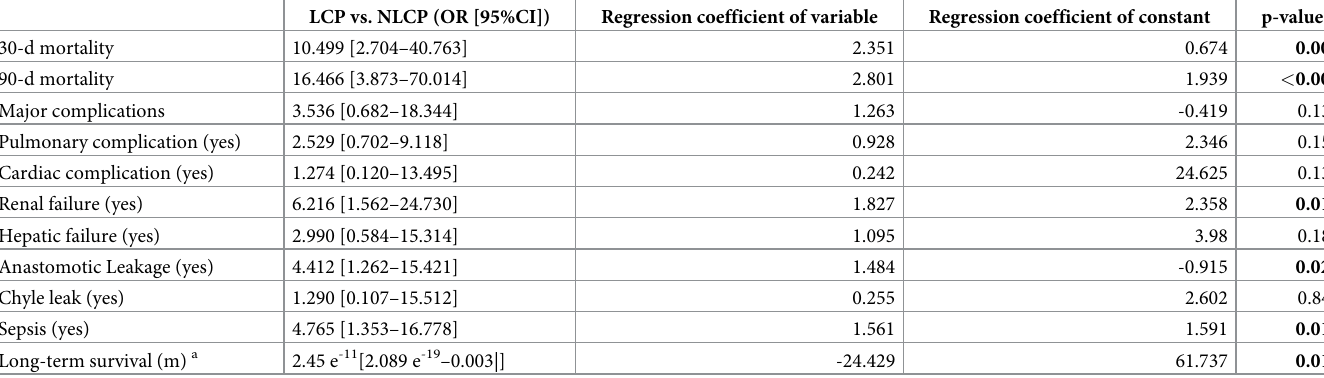
Table 4. Risk-adjusted analysis of postoperative outcomes of cirrhotic and non-cirrhotic patients.